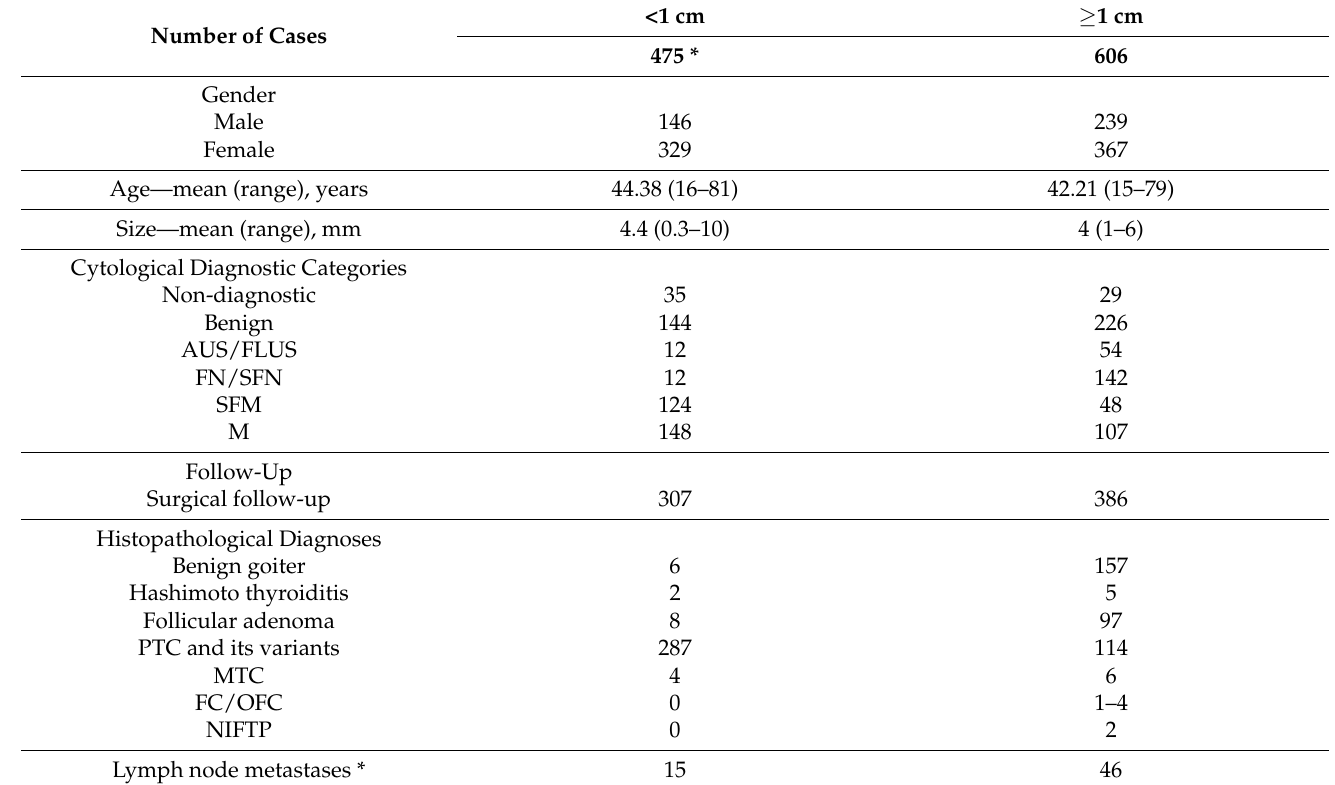
Table 1. Summary of clinical/pathologic